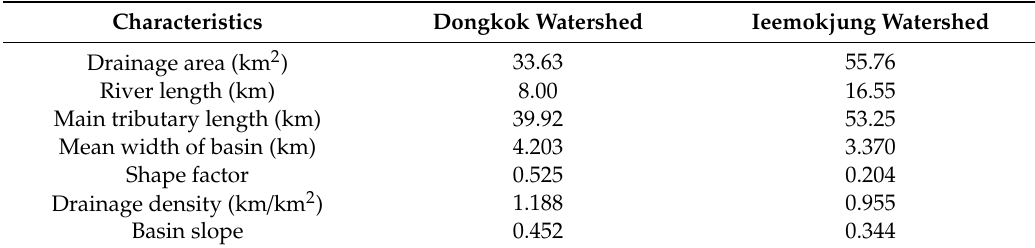
Table 1. Topographic characteristics of the Dongkok and Ieemokjung watersheds.